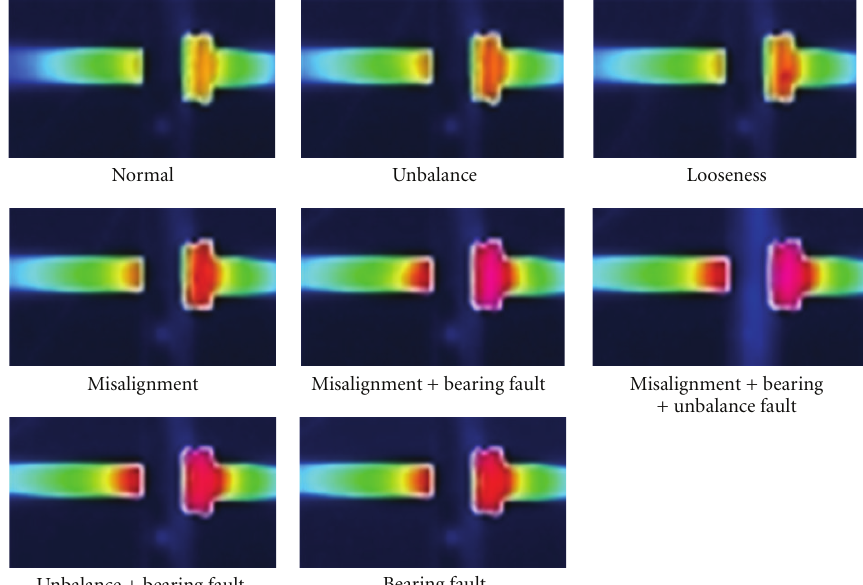
Figure 8: Thermal images of left